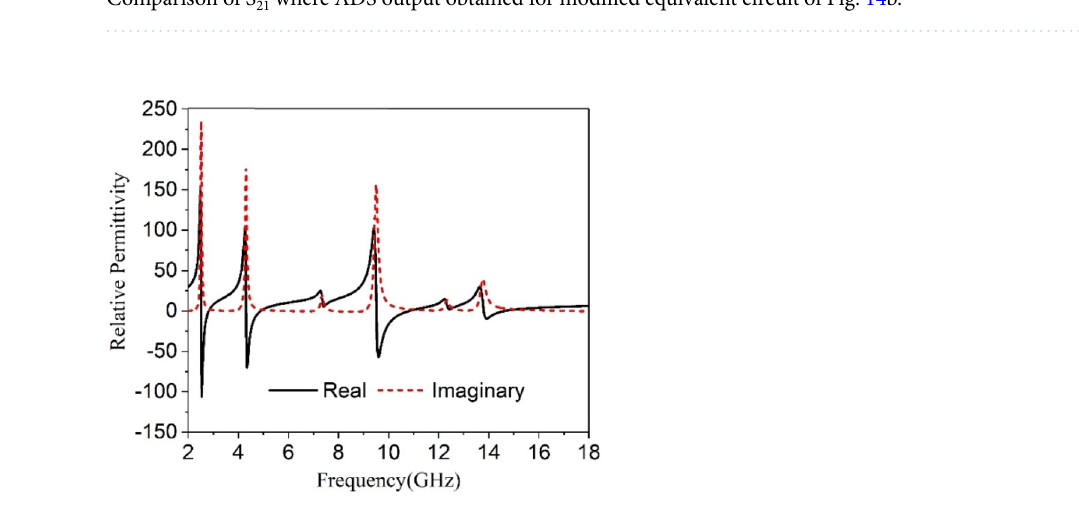
Figure 16. Real and Imaginary part of relative